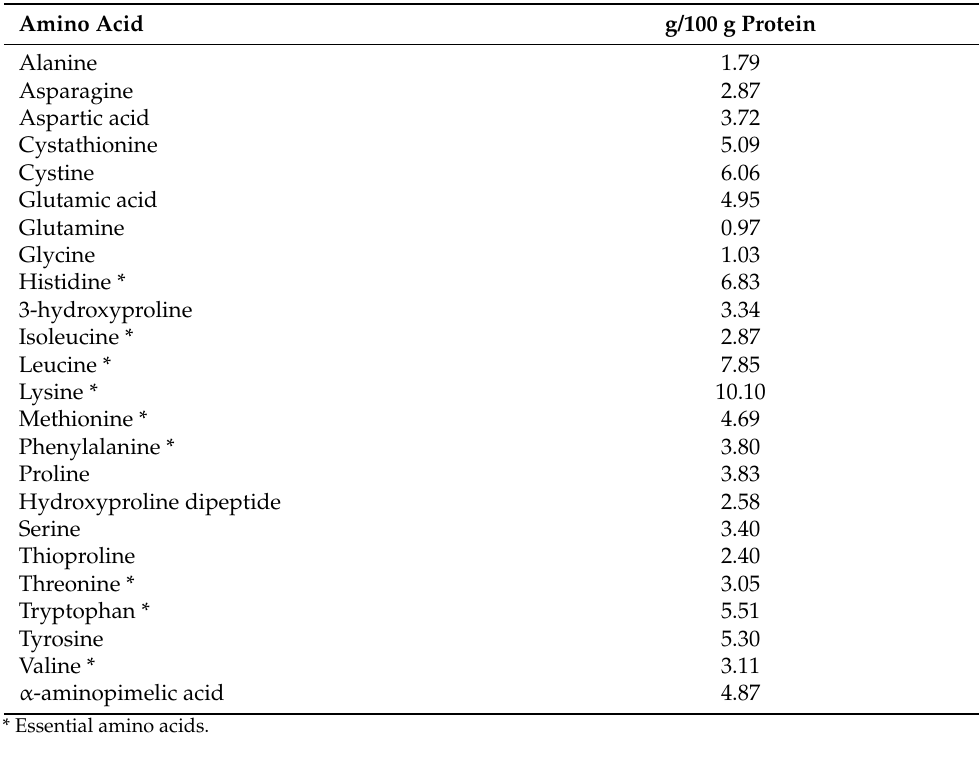
Table 5. Amino acids present in amaranth seed.